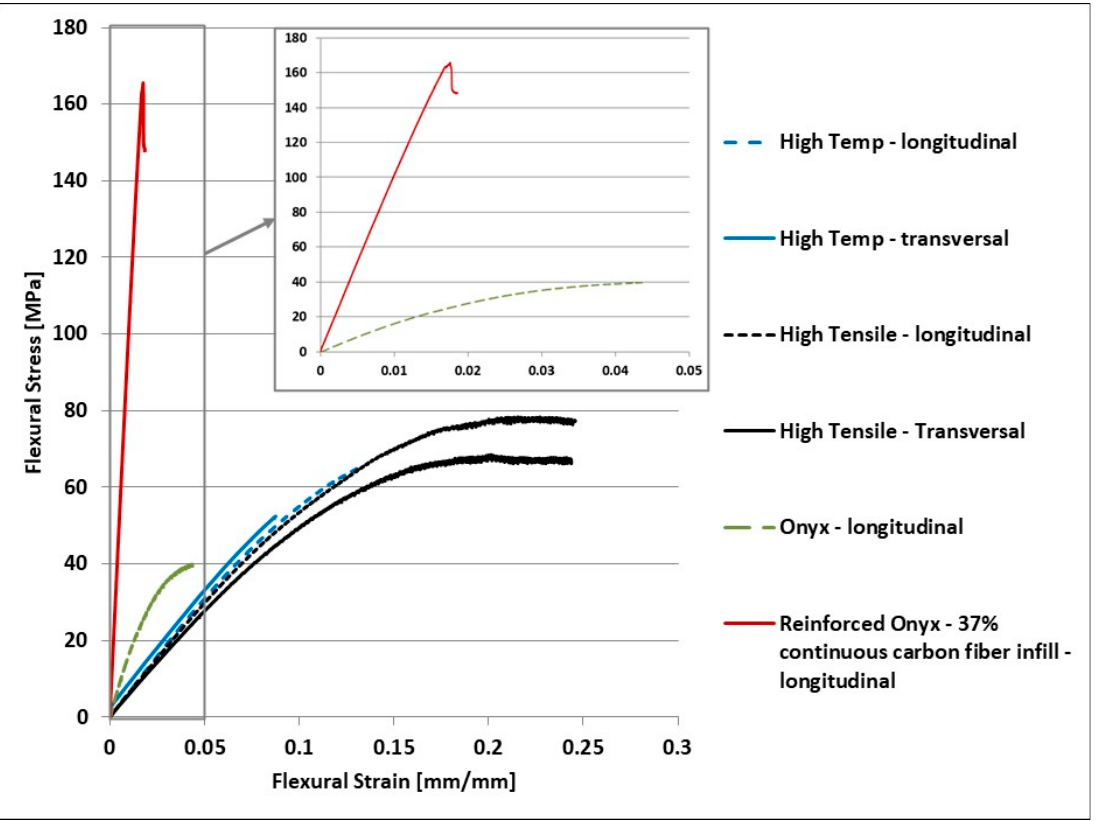
Figure 10. Average stress–strain curves in the 3-point bending flexural test.